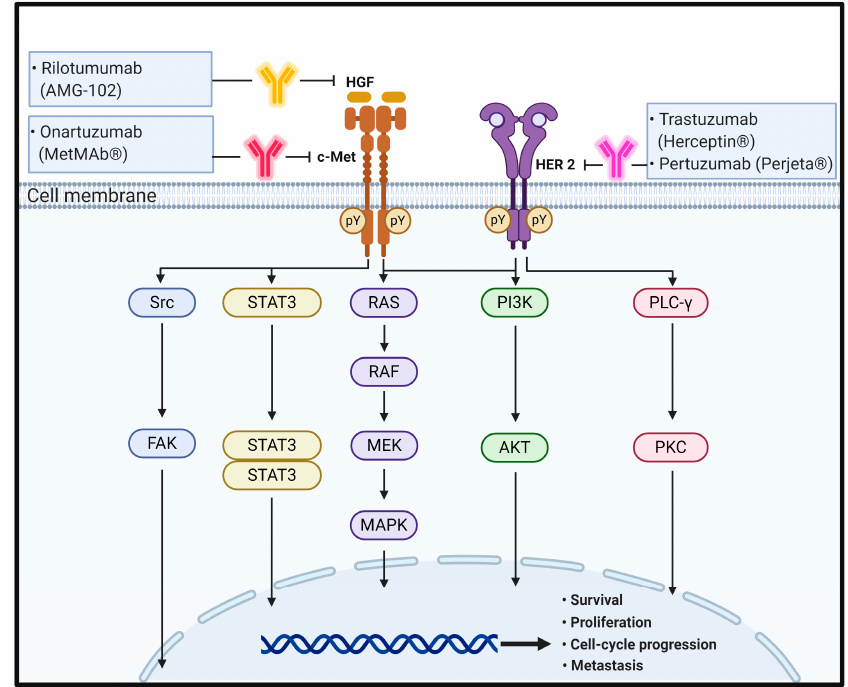
Figure 2. The schematic representation of the physiological roles and signaling pathways of HGF/c- MET and HER2 and effect of antibodies targeting these signaling molecules on CRC progression and metastasis. pY means phosphotyrosine residues.